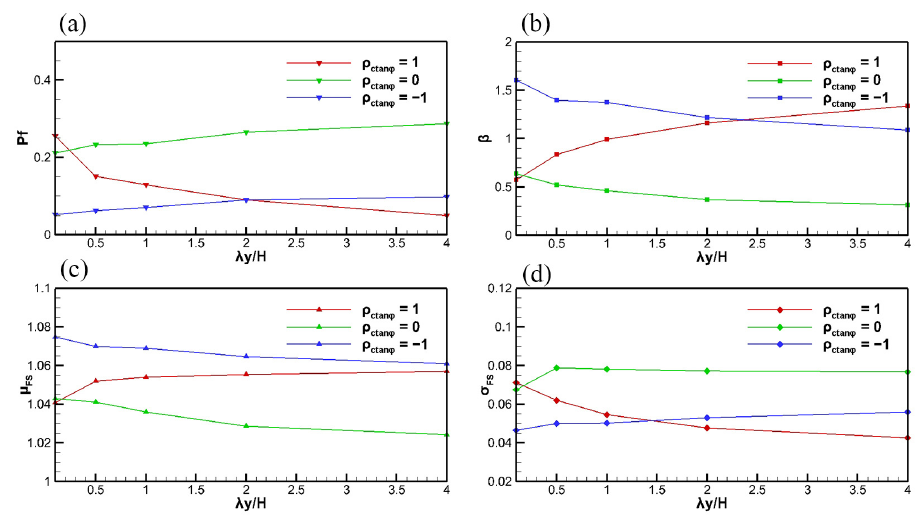
Figure 8. ( a – d ) are pf , β , μ FS , and σ FS of FS obtained by MCS for different λ y and ρ c tan φ values.